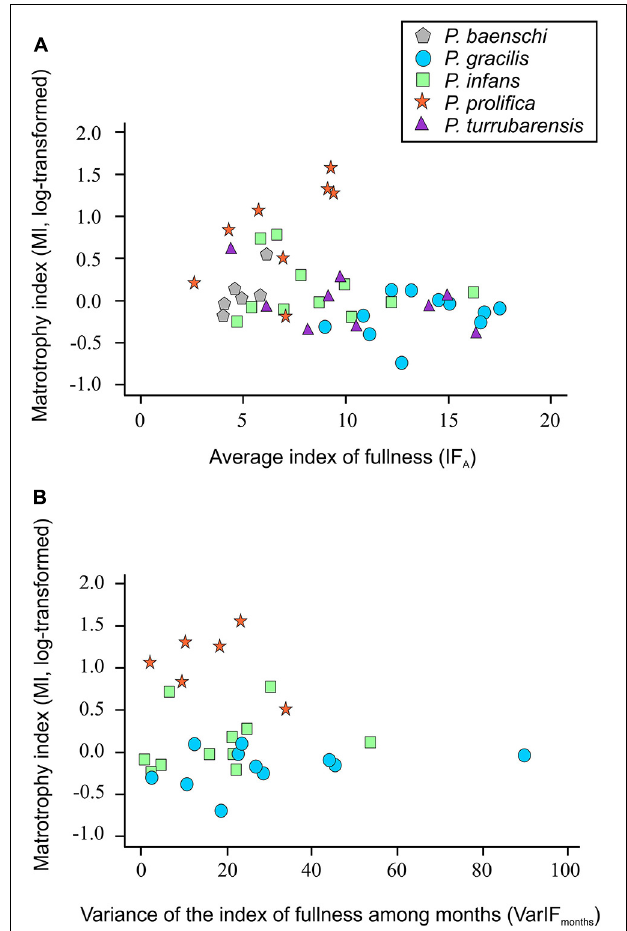
FIGURE 1 | (A) Lack of association between the matrotrophy index per population (MI) and average index of fullness (IF A ) for 45 populations of five fish species from the genus Poeciliopsis . (B) Lack of association between the MI per population and the variance of the index of fullness among months (VarIF months ) for 28 populations of three fish species from the genus Poeciliopsis